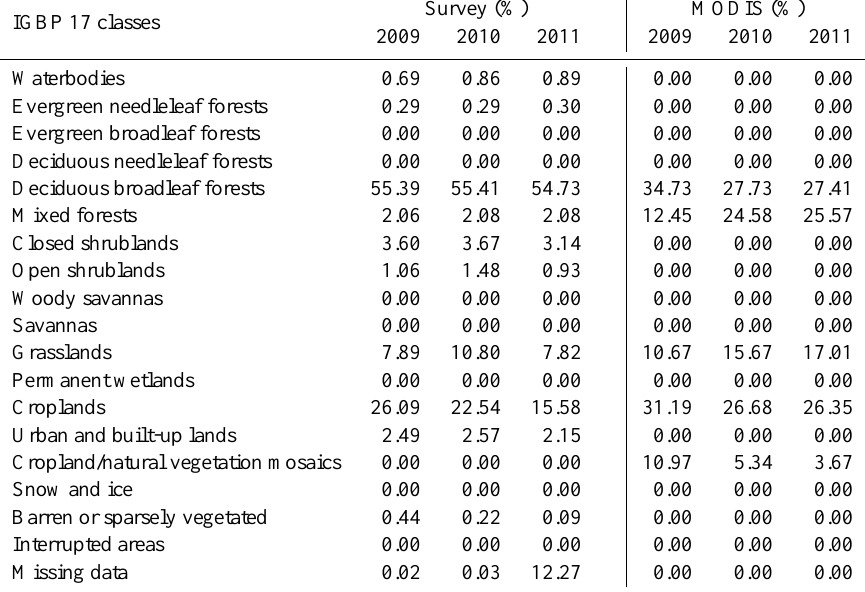
Table 8. Changes of land use and land cover according to the IGBP 17-class system. The columns under “survey” refer to the survey data and those under “MODIS” to MODIS Land Cover Type (MCD12Q1) following the same classification system. Note that the “waterbodies” and “urban” classes were not detected by MODIS, presumably as a result of coarse resolution (500m). Note that the survey data of 2011 are